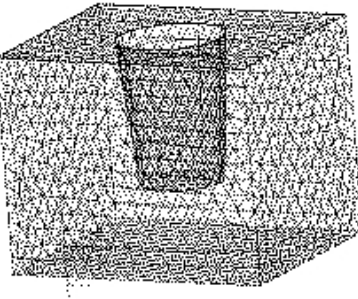
Fig. 11. Meshing of the surfaces for the plastic-cup mold.